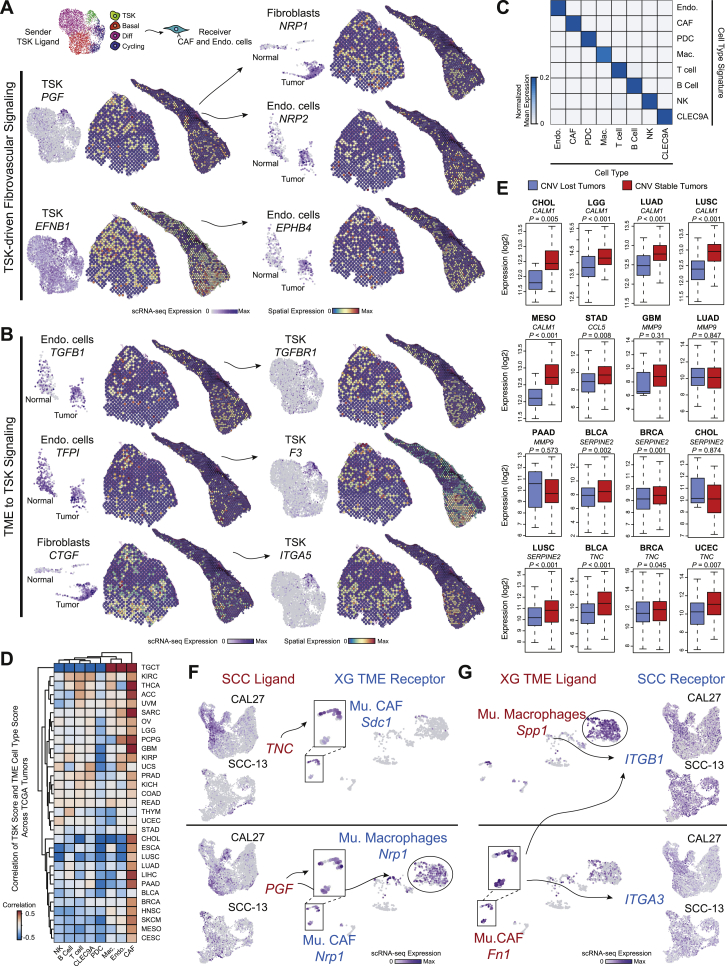
Ligand-Receptor Crosstalk in the TSK Niche, Related to Figure 6(A) UMAP scRNA-seq (N = 7 patients) and spatial feature plots (N = 2 patients) of ligand-receptor and cell type pair expression highlighting TSK signaling to cancer-associated fibroblasts (CAFs) and endothelial cells. (B) UMAP scRNA-seq (N = 7 patients) and spatial feature plots (N = 2 patients) of ligand-receptor and cell type pair expression highlighting CAF or endothelial cell signaling to TSK. (C) Heatmap of average TME cell type signature expression across TME cell types in scRNA-seq data (D) Correlation heatmap of TME cell type signatures (columns) each correlated with the TSK signature across TCGA cancers (rows). (E) Boxplots showing RNA expression across TCGA cancers of specific genes in copy number variant (CNV) lost or stable tumors. P value was determined by Kolmogorov-Smirnov test. (F) UMAP feature plots of select ligands expressed by SCC cells and cognate receptors expressed by murine TME cell types. (G) UMAP feature plots of select ligands expressed by murine TME cell types and cognate receptors expressed by SCC cells.